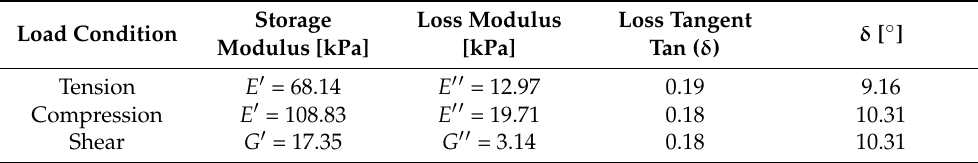
Table A1. Viscoelastic parameters resulted from the fitting of experimental data at 1 Hz, 20%